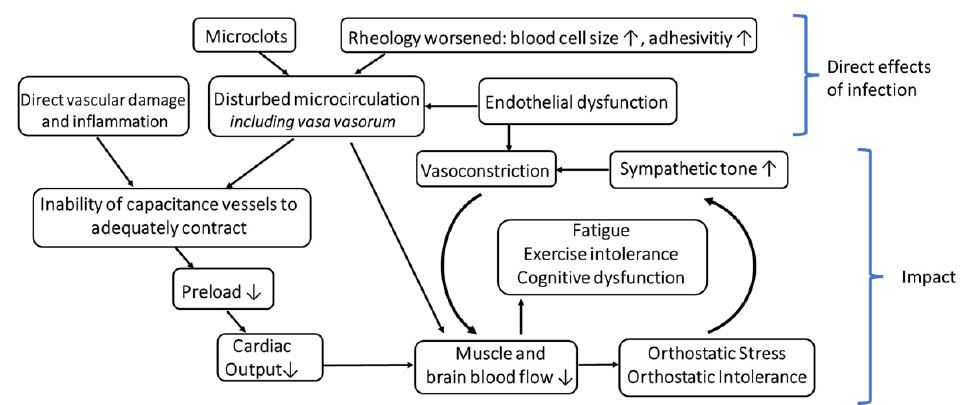
Figure 1. Hypothetical Role of the Capacitance Vessels and their Vasa Vasorum in Orthostatic Intolerance in the Post-COVID-19 Syndrome.